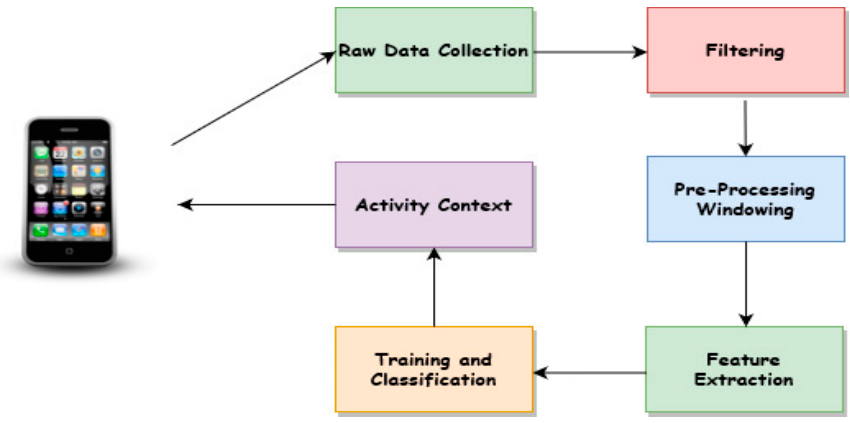
Figure 1. Classical activity context recognition processes.